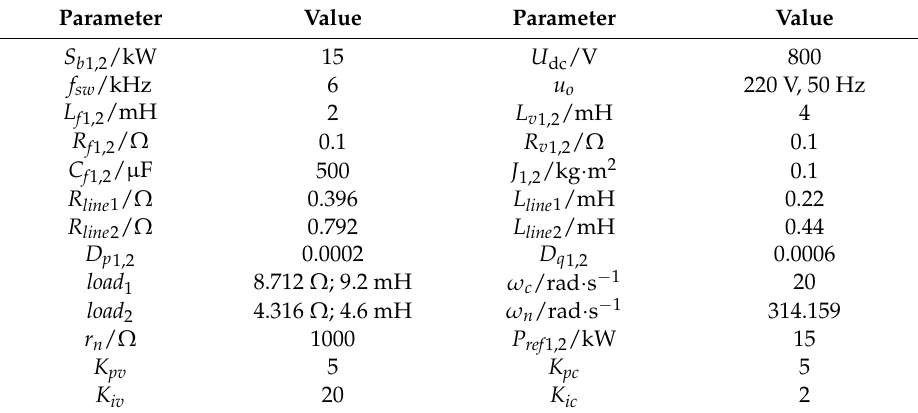
Table 2. The parameters and initial